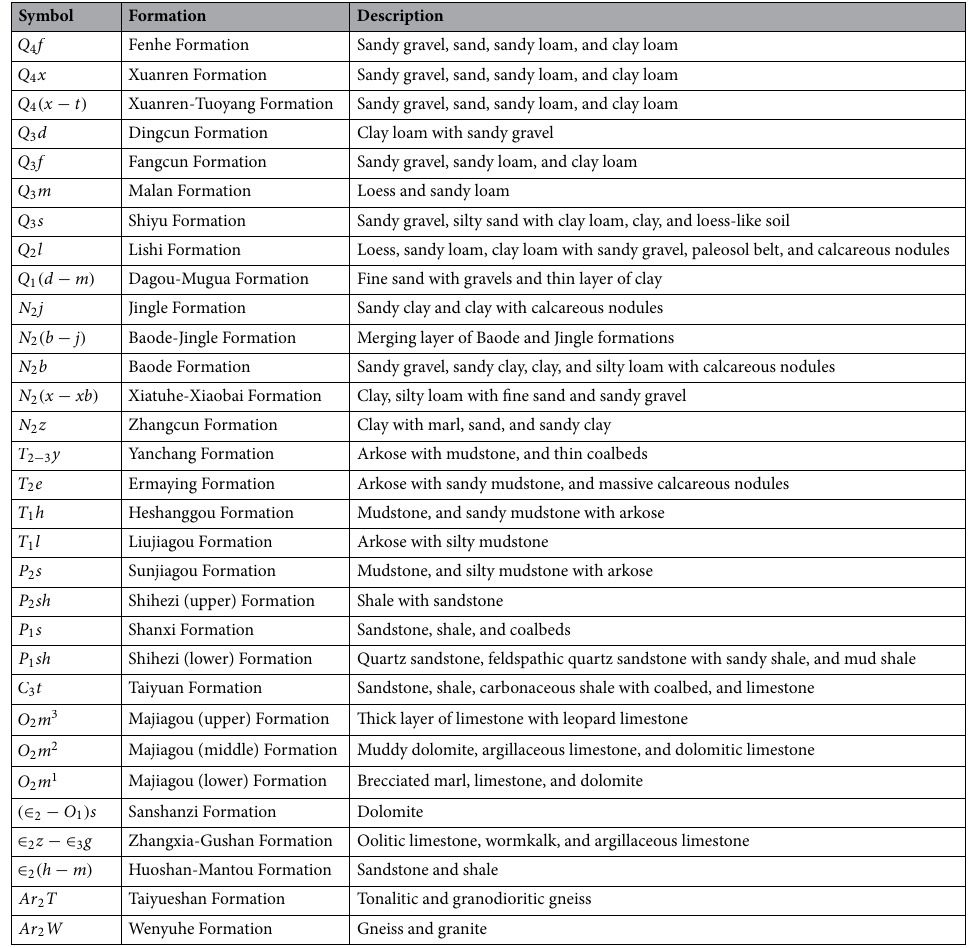
Table 1. Geologic formations in the study area (adapted from the China Geological Survey).